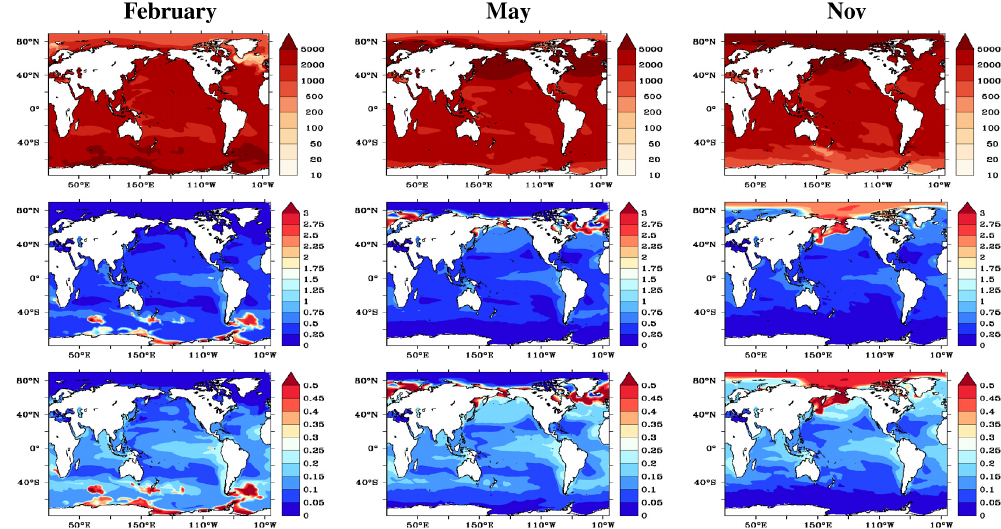
Figure 7. Global estimates of effective enrichment and organic mass fractions. Case BASE: using model compounds as described in Table 1. Top: effective mass enrichment ratio. Middle: OM:Na mass ratio in nascent film drop aerosol. Bottom: organic mass fraction in nascent film drop aerosol. Left: February. Center: May. Right: